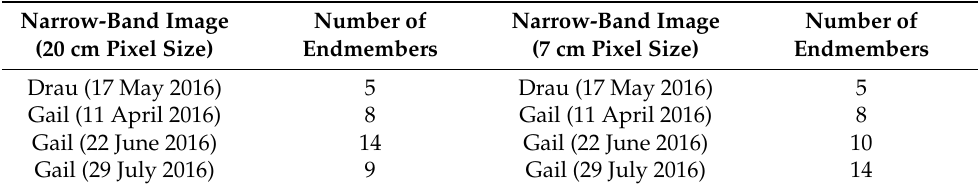
Table 6. Number of endmembers extracted using the Sequential Maximum Angle Convex Cone (SMACC) algorithm for the narrow-band